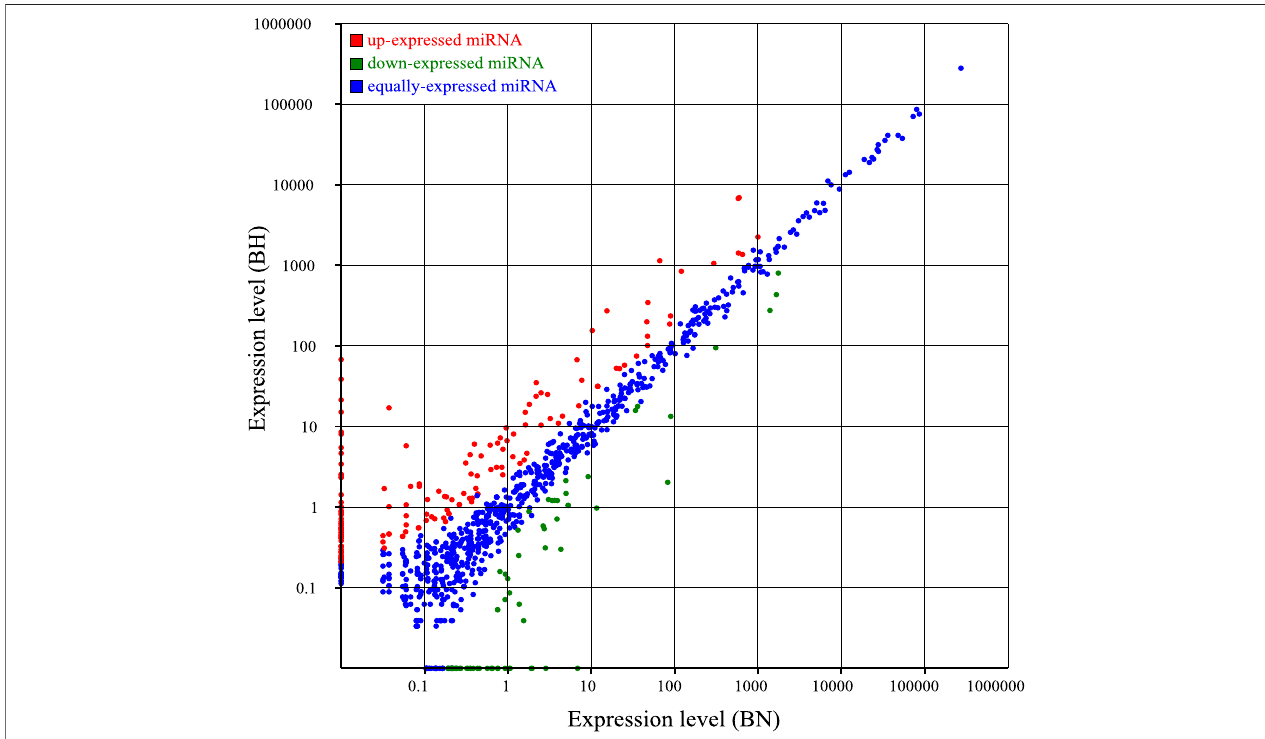
FIGURE 4 | Scatter plots for differential expression miRNAs between blind-side normal skin (BN) and blind-side hypermelanotic skin (BH).